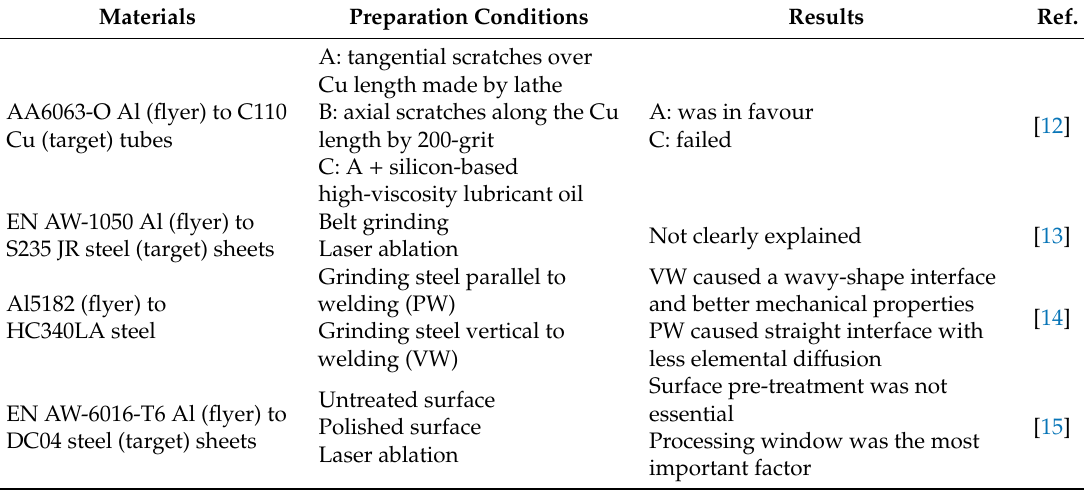
Table 1. A summary of related studies on the influence of surface preparation for MPW